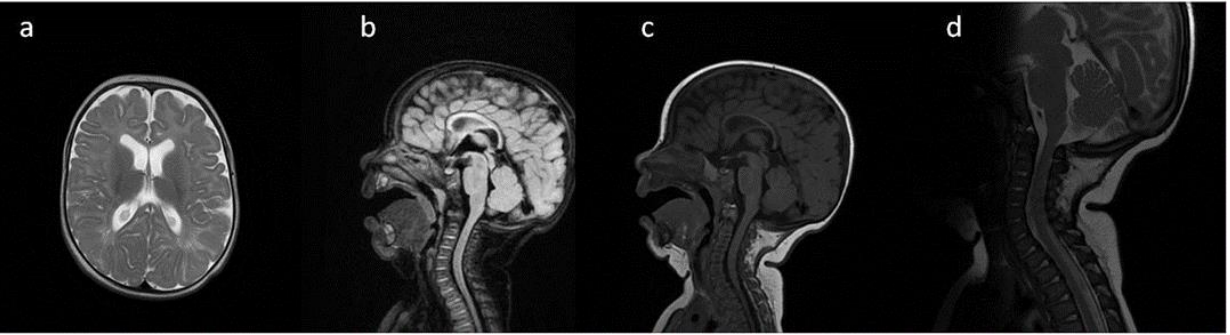
Figure 1. Brain and cervical spine MRI. Patient 1. (younger sister) ( a ) axial T2; ( b ) sagittal T2 FLAIR, ( c ) sagittal T1; ( d ) sagittal spinal T2. Findings: delayed myelination, slight skiboot sella turcica shape; suspicion of dens hypoplasia — for observation (age 4 mo).